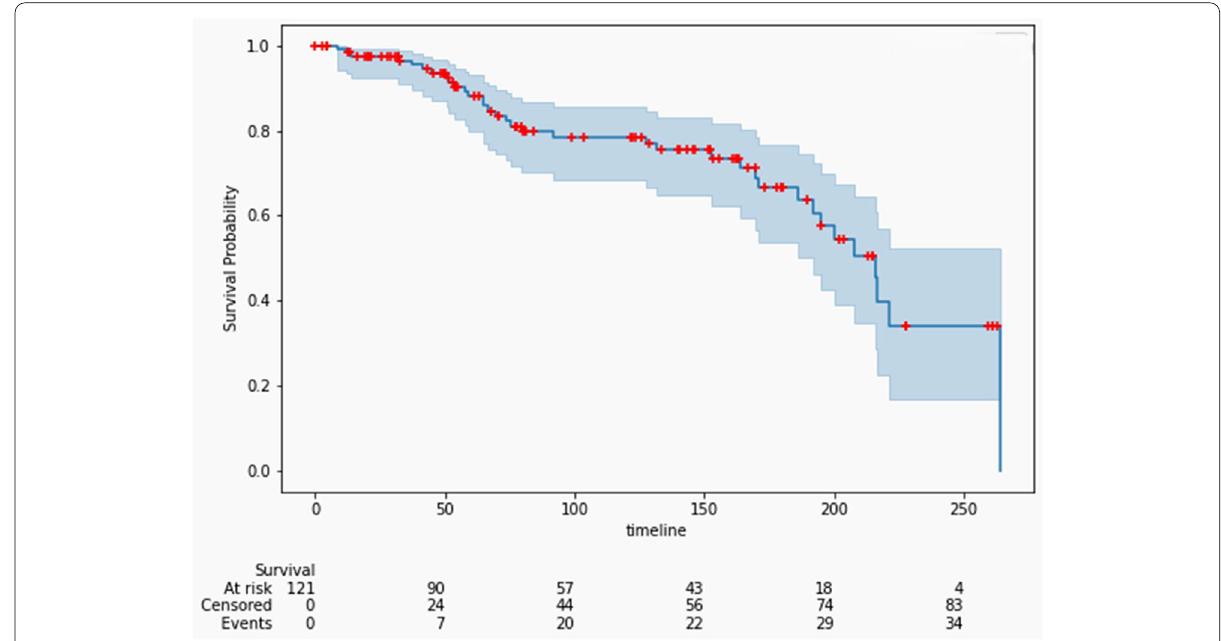
Fig. 5 The Kaplan–Meier survival curve of 121 patients with multiple primary